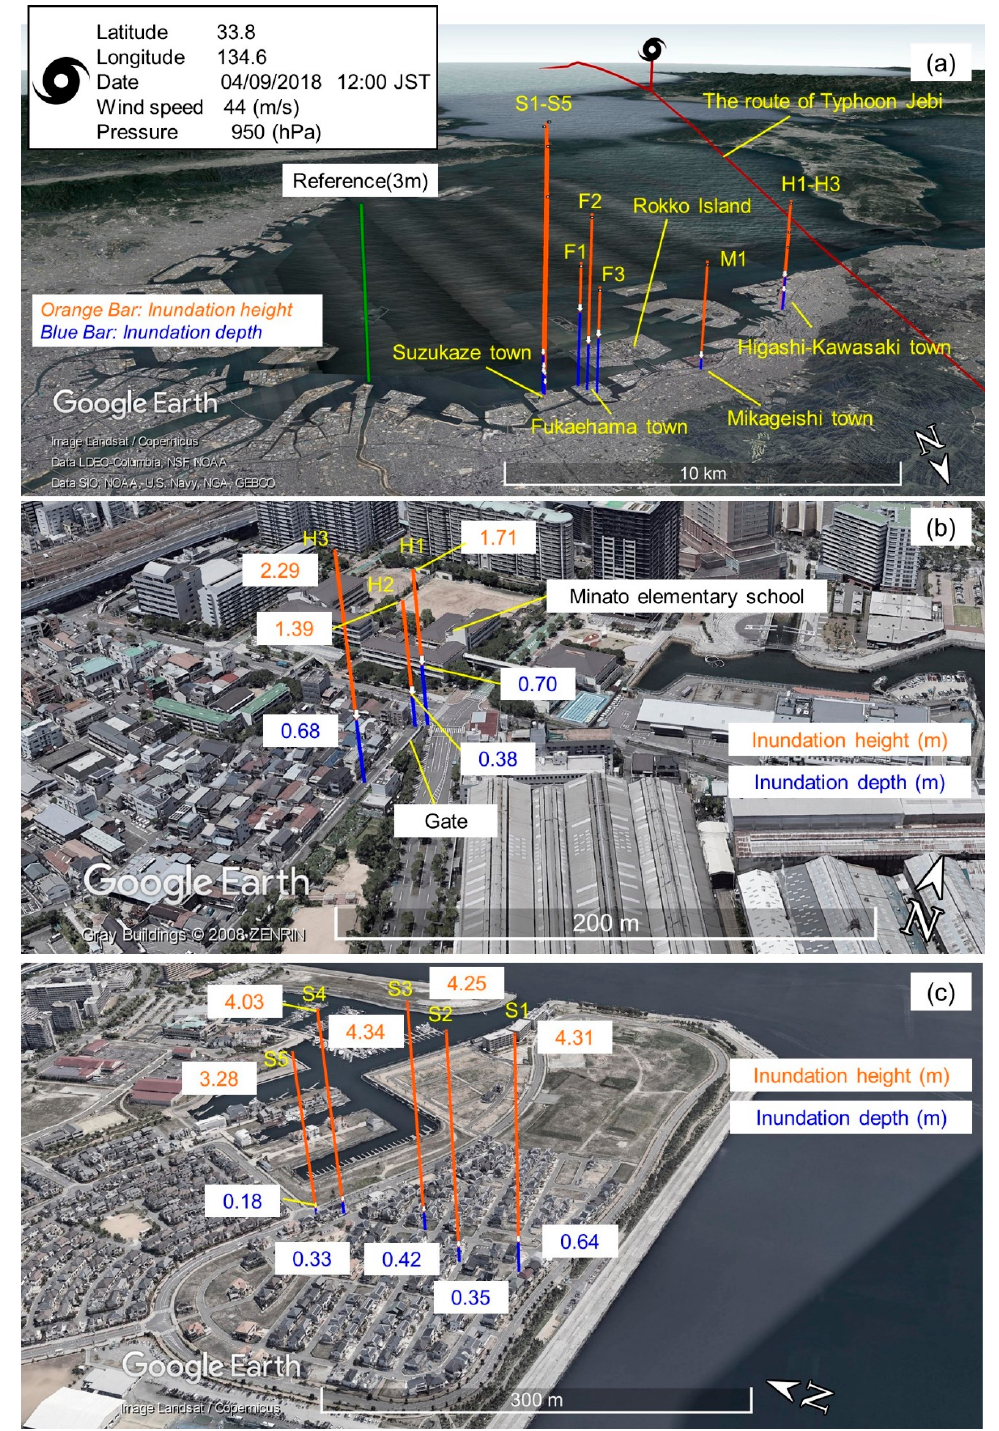
Figure 4. Survey locations; ( a ) Survey locations and measured inundation height (orange) and inundation depth (blue) along Osaka Bay, showing also the path of Typhoon Jebi (red line); ( b ) details of inundation height and inundation depth at Higashi-Kawasaki town; and ( c ) Suzukaze town. The measurement heights are exaggerated 2000:1 in ( a ) and 50:1 in ( b , c ).